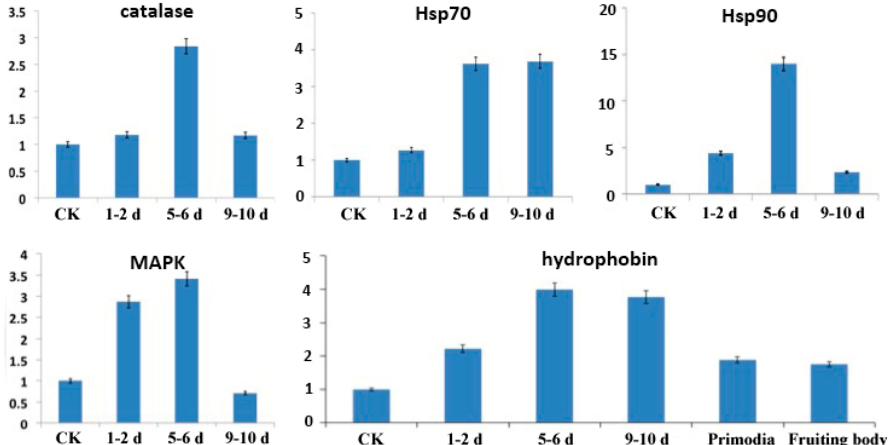
Figure 4. qRT-PCR analysis of selected genes in mycelia during the physiological after-ripening stage (control (CK) = 25 °C) and different cold stimulation stages (1–2 d, 5–6 d, and 9–10 d at − 3 °C). Transcript levels of five genes (PoH2-type hydrophobin, MAPK (mitogen-activated protein kinase hog1), catalase, Hsp70 (heat shock protein 70) and Hsp90 (heat shock protein 90)) that appeared to be up-regulated in all cold stimulation stages compared to the physiological after-ripening stage. The X-axis represents relative quantification of transcript levels of the three selected genes, and the Y-axis represents the control and the three sampling times after cold stimulation.